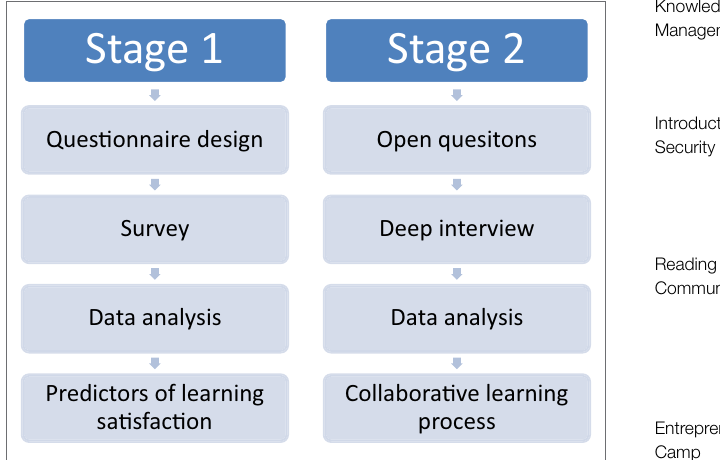
FIGURE 1 | Two-staged research design.